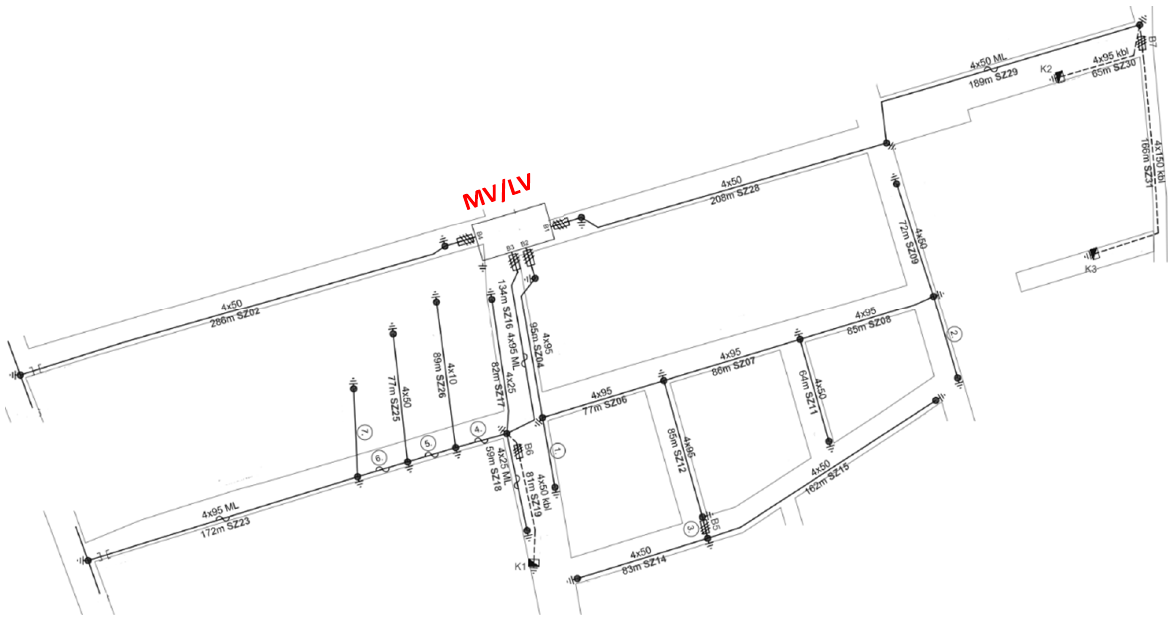
Figure A2. Topology of area 44333 (MV/LV represents the supplying medium/low-voltage trans- former).